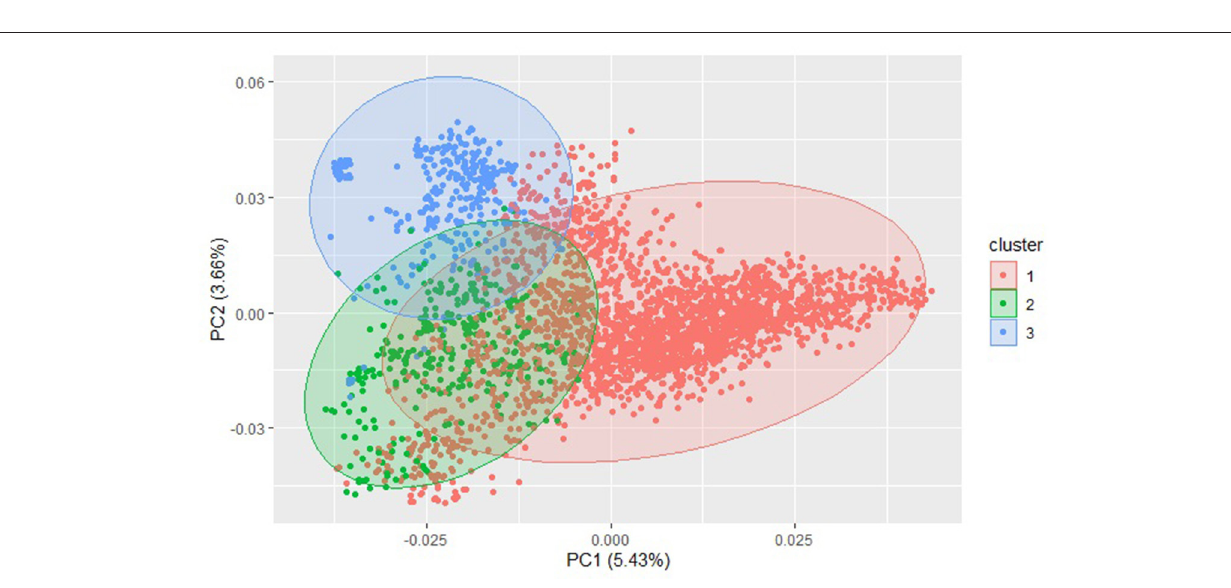
using 2013–2017 to predict 2018 ( Supplementary Tables 6 , 7 ). In the last validation set, GWAS had the largest prediction accuracy of 0.55 for IT. Similarly, the smaller GWAS sets had the highest prediction accuracy. In contrast to the cross-validations, the larger GWAS sets did not have a drastic decrease